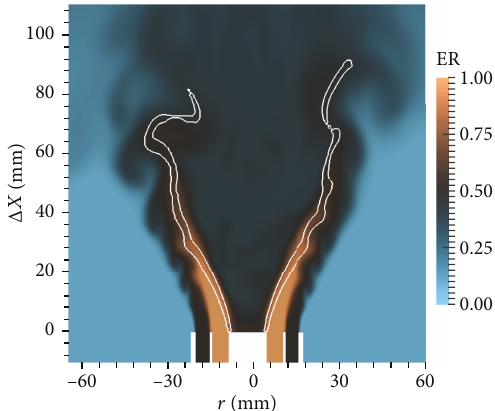
Figure 17: Snapshot of instantaneous and mean CH of Mech II simulation.